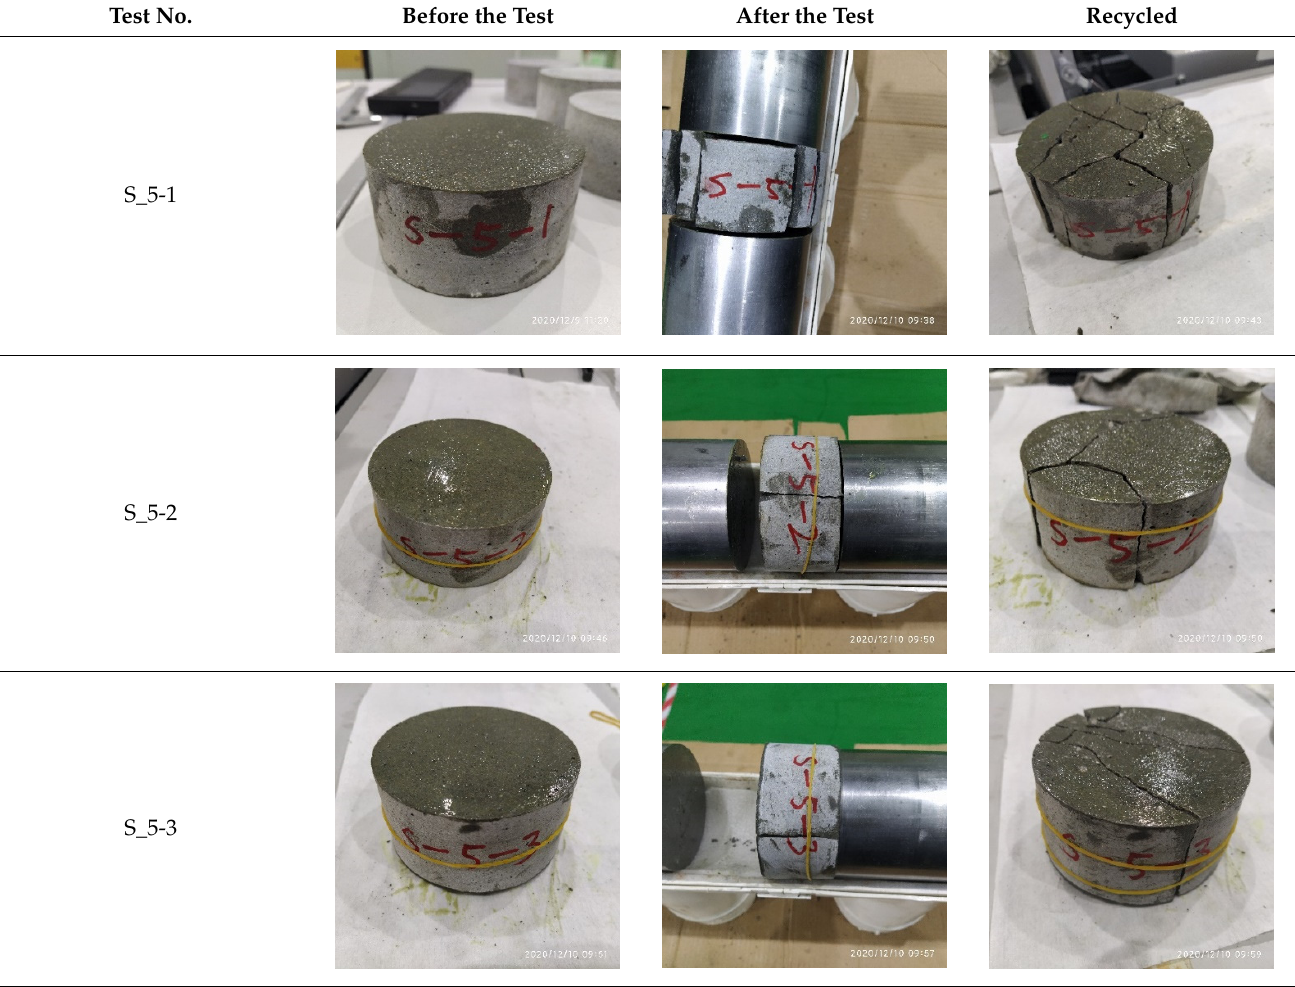
Figure 5. Stress–strain curve of 5 m/s.